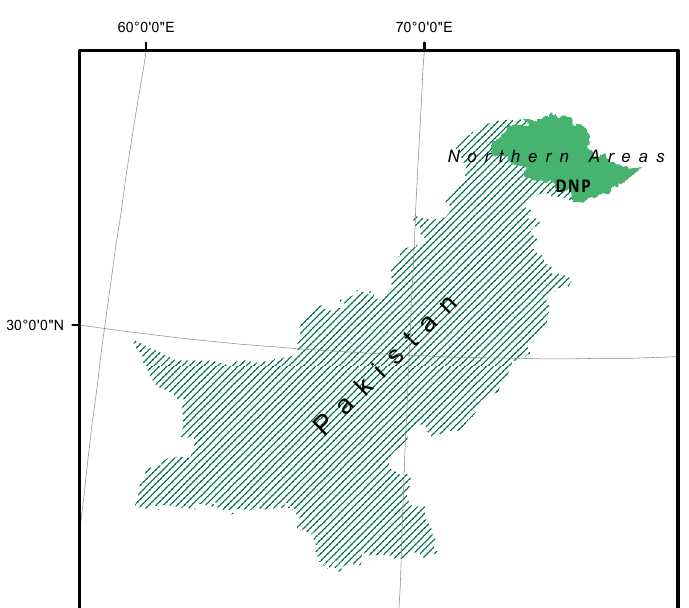
Figure 1. Localization of the Deosai National Park (DNP) in the Deosai Plateau in the Northern Areas region of Pakistan.